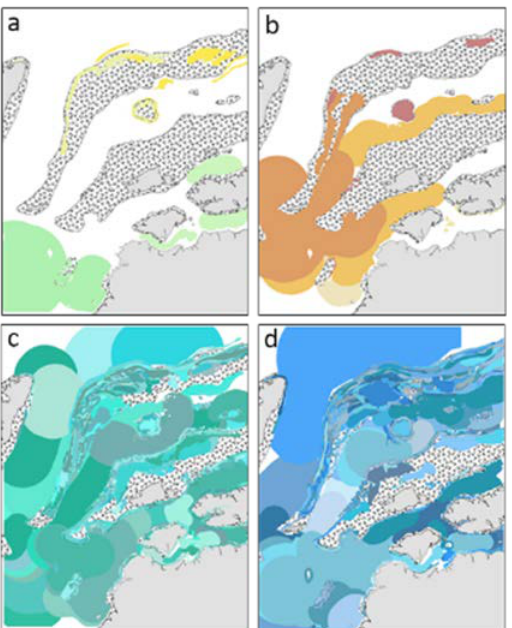
Figure 4. Estimated extent of fishing using small (panels a , b ) and large (panels c , d ) numbers of respondents. Maps depict overlap of fishing grounds from random subsets of fishers with small ( n = 5) and large ( n = 125) numbers of respondents.